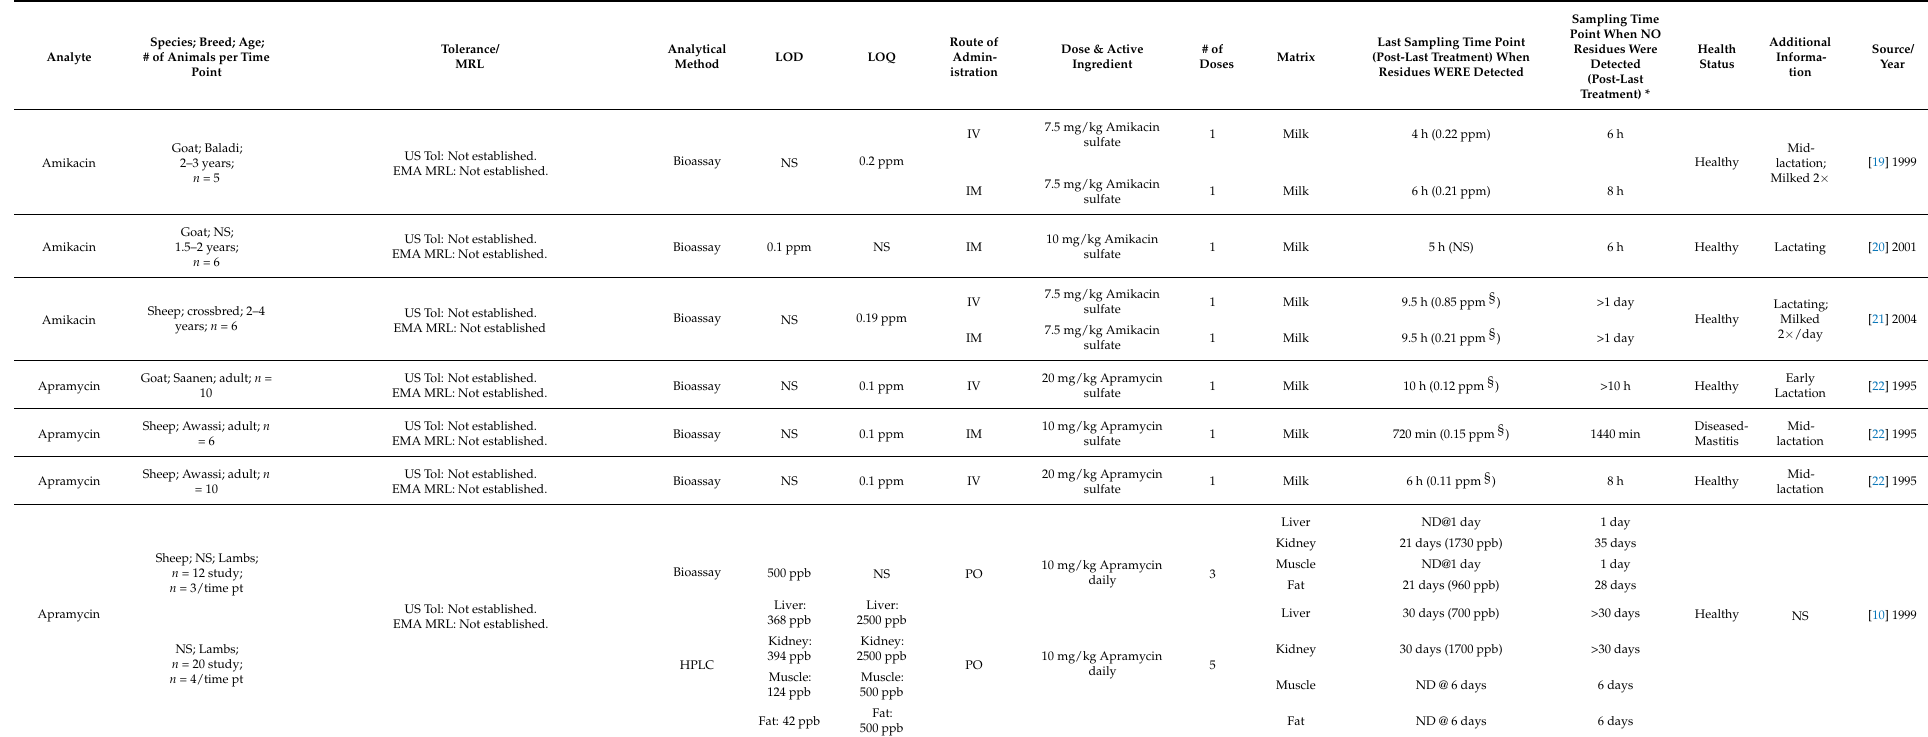
Analytical Method LOD LOQ